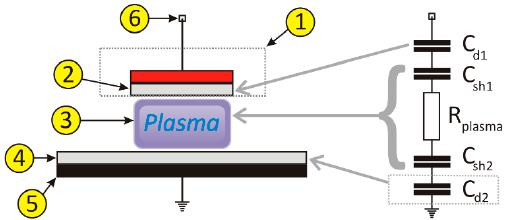
Figure 6. The plasma electrical model we used in our calculations; ( 1 )—the cold plasma applicator head assembly, ( 2 )—the dielectric covering of the plasma applicator’s inner electrode, ( 3 )—plasma discharge, ( 4 )—the dielectric sheet which covers the ground plane (this element may be nonexistent in some application examples), ( 5 )—ground plane, ( 6 )—high voltage connector of the plasma applicator.